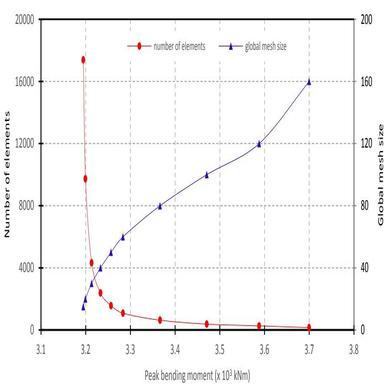
Mesh sensitivity analysis results for YPT X70 pipe (YPL = 2.0; fp = 0).